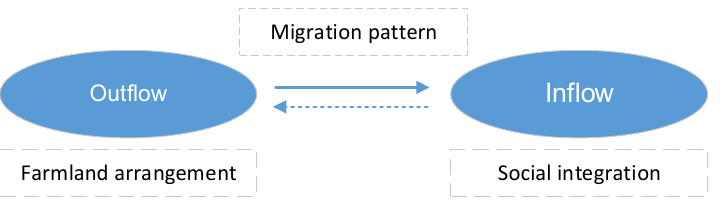
Figure 2. Relationship between representative indexes and the migration system.